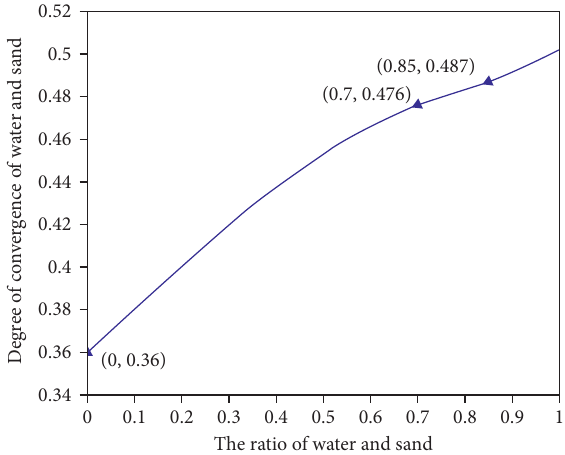
Figure 3: Convergence of water and sand.